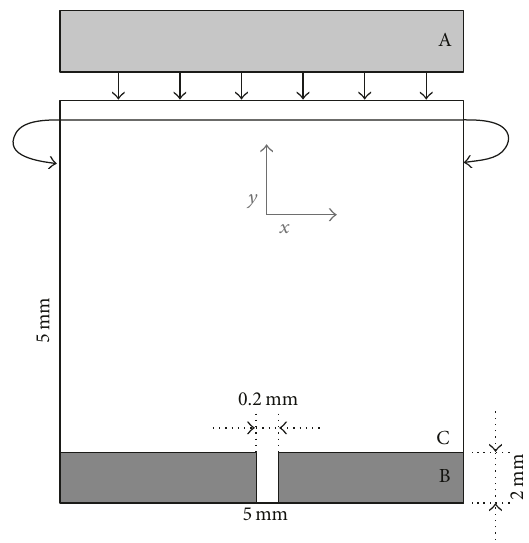
Figure 1: Scheme of the computational domain. A: source of particles, Dirichlet boundary condition 𝑈 = 0 V was applied on this side. B: trenched substrate, Dirichlet boundary condition 𝑈 = 𝑈 𝑏 . C: computational domain, period boundary condition was applied on remaining sides of the